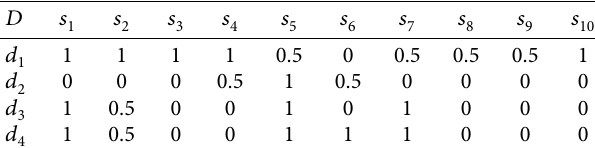
Table 15: Tabular representation of ( G,S ) (Part 1).